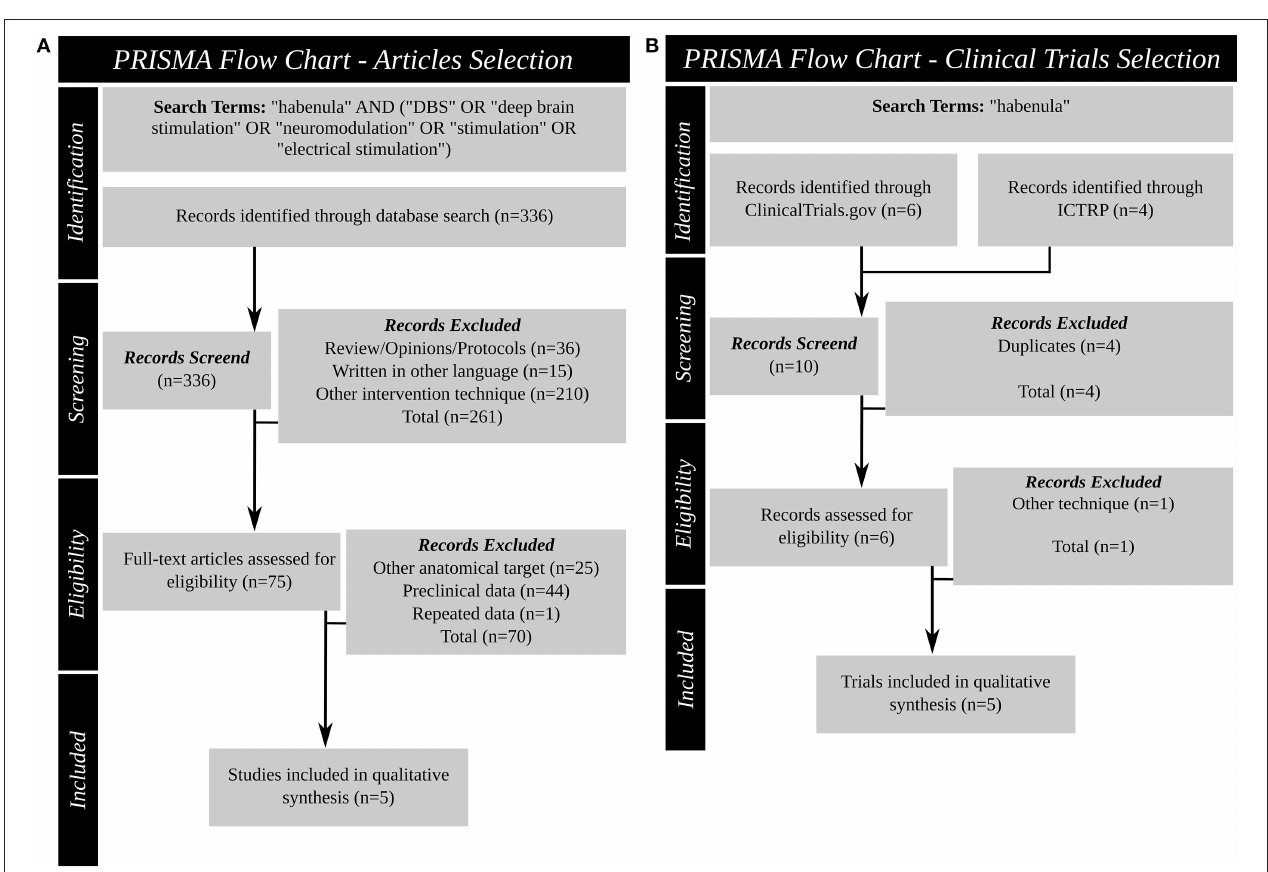
FIGURE 3 | Systematic review PRISMA figures. (A) : Article search (B) : Clinical trial database search. DBS, deep brain stimulation; ICTRP, international clinical trials registry platform; PRISMA, Preferred Reporting Items for Systematic Reviews and Meta-Analyses.